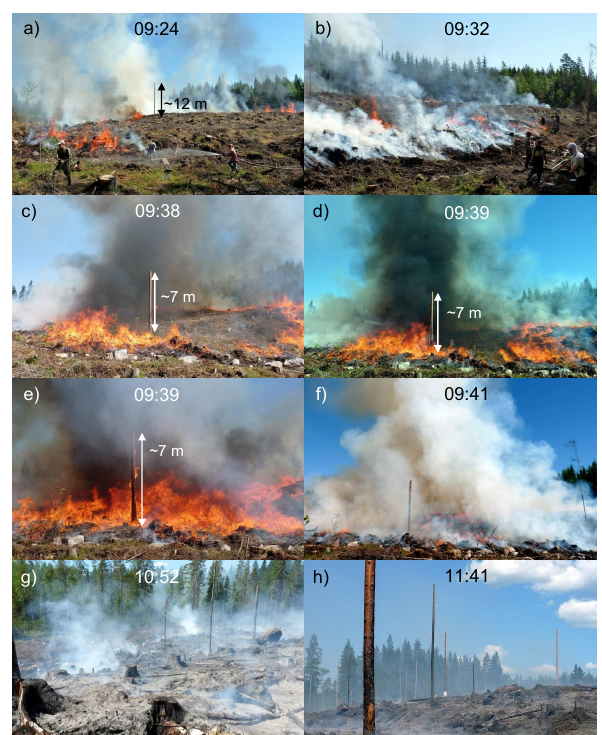
Fig. 2. Photographs of the burn area during the flaming phase (a–f) and the smoldering phase (g, h)